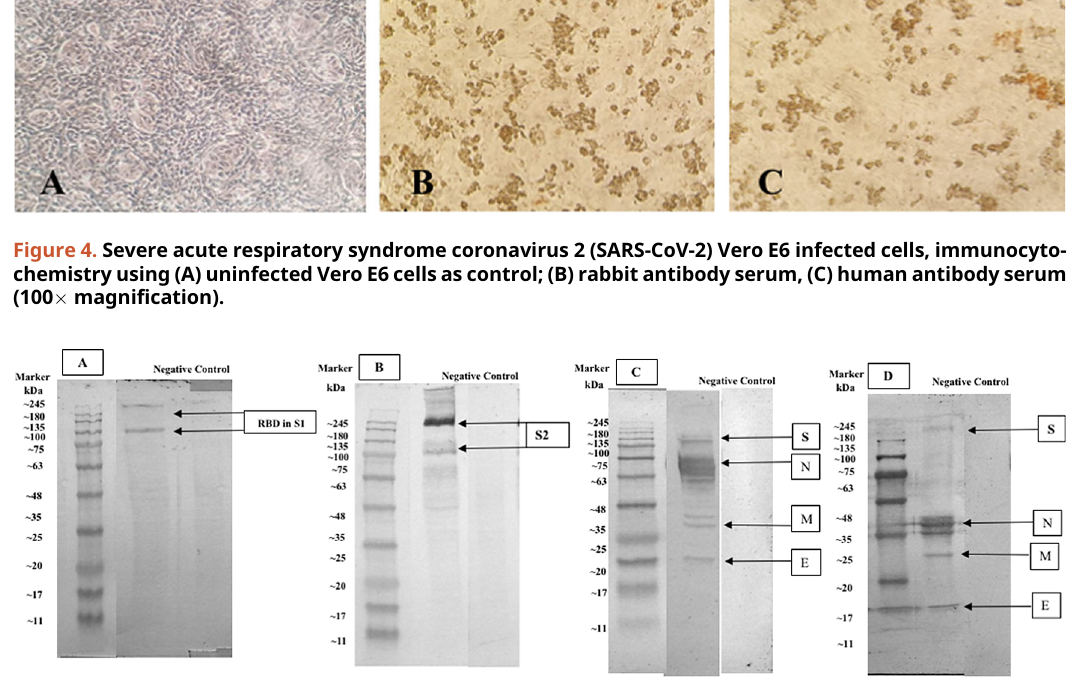
Figure5.Severeacuterespiratorysyndromecoronavirus2(SARS-CoV-2)westernblotstainingwithanti-SARS- CoV-2ReceptorBindingDomain(RBD)monoclonalantibodyfordetectingS1protein(MAB10540,RnDSystem) (8%gel);(A):westernblotstainingwithanti-SARS-CoV-2S2monoclonalantibody(MAB10557,RnDSystem)(8% gel); (B): western blot staining with rabbit antibody serum (12% gel); (C): western blot staining with human convalescent serum from the COVID-19 infection (8% gel); (D): (S) labeled for spike protein, (N) labeled for nucleoprotein protein, (M) labeled for membrane protein, (E) labeled for envelope